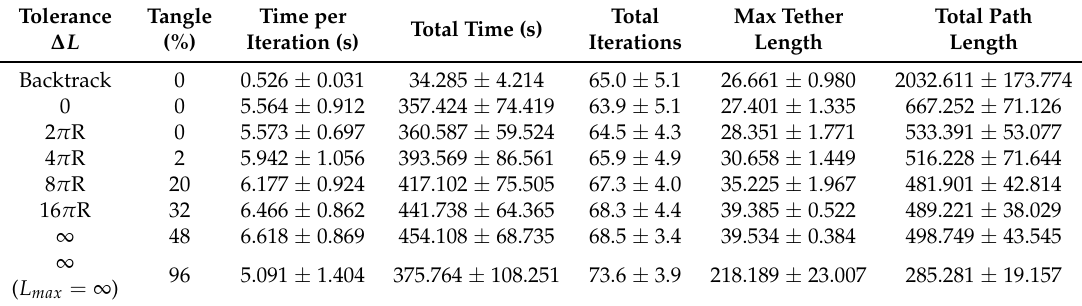
Table 3. Simulation data for large environment. 40 × 40 map, 0.5 resolution, tether length 40, 40–50 obstacles of radius up to 2. Tether base is at [20, 20], and the field of view is set to